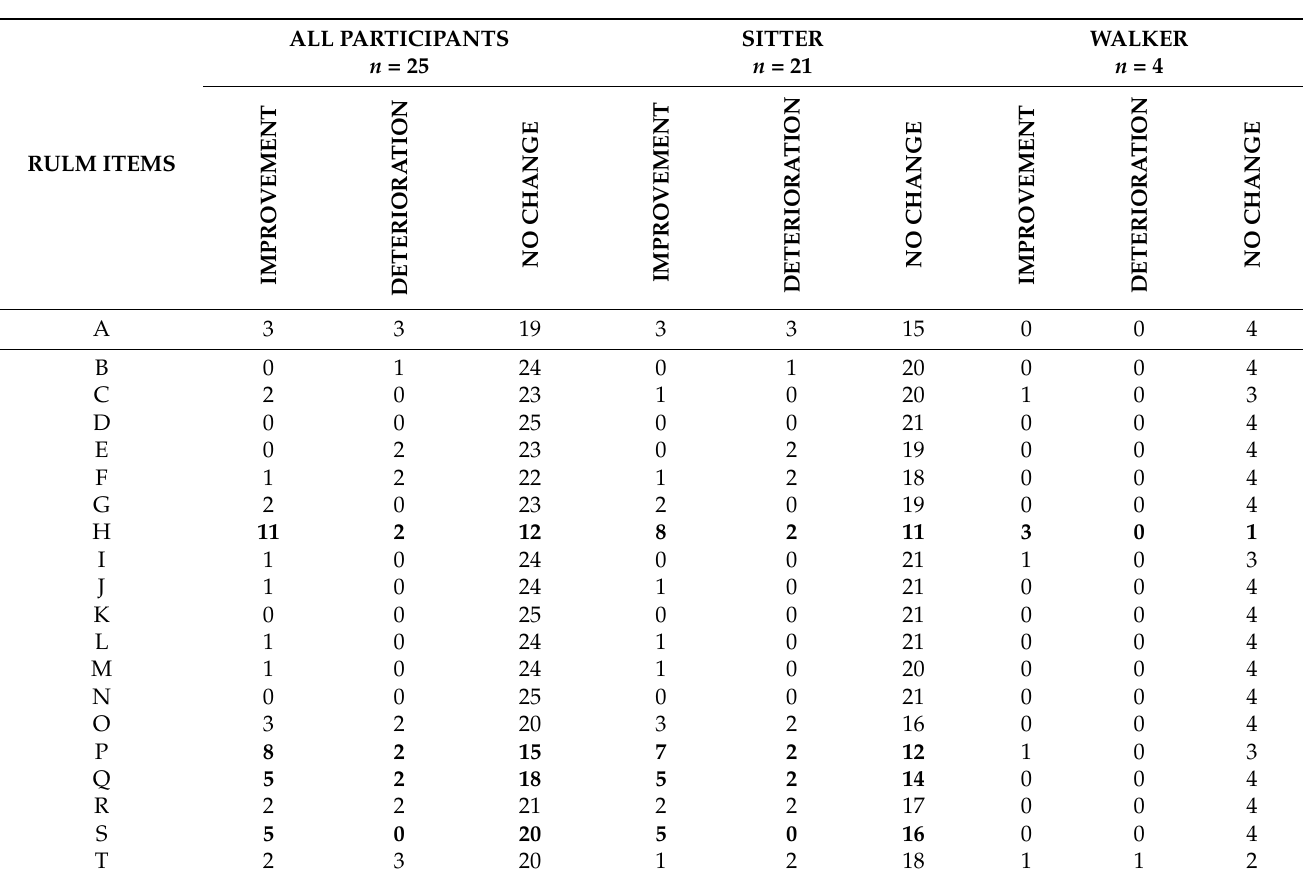
Table 4. Number of children with improvement, deterioration, or without change in individual RULM items (A, B–T). The most improved items are marked in